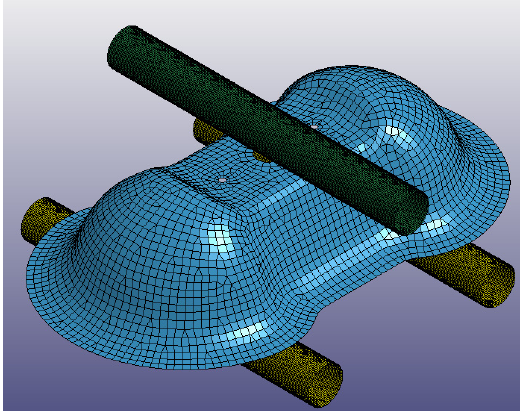
Figure 17. FEA model of three-point bending test on Double Dome.